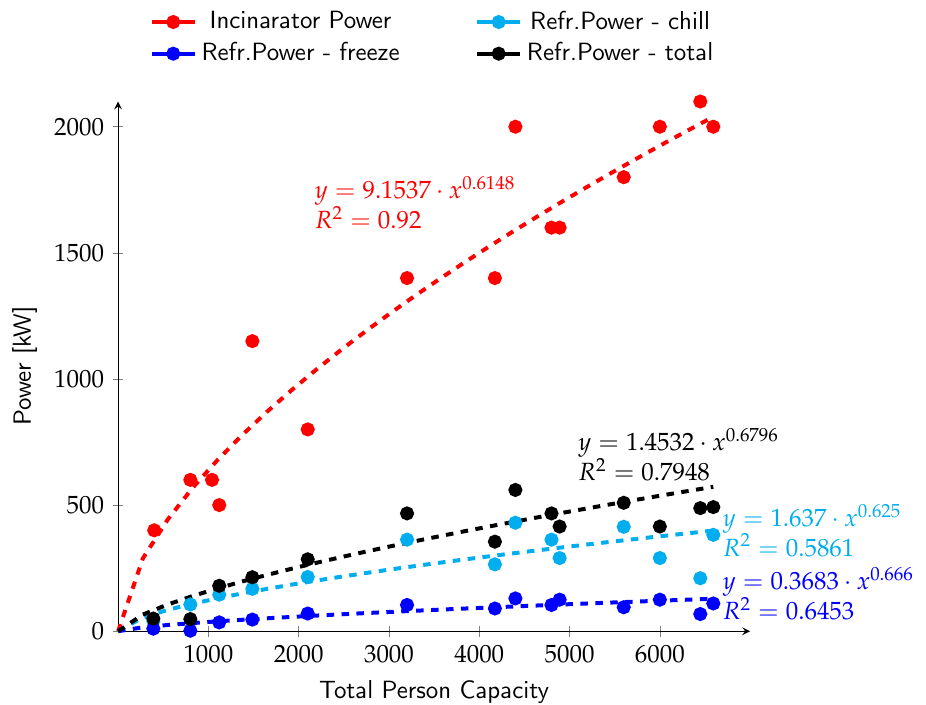
Figure 5. Power of the incinerator and the refrigeration plants compared to TPC (DATA: courtesy of Fincantieri